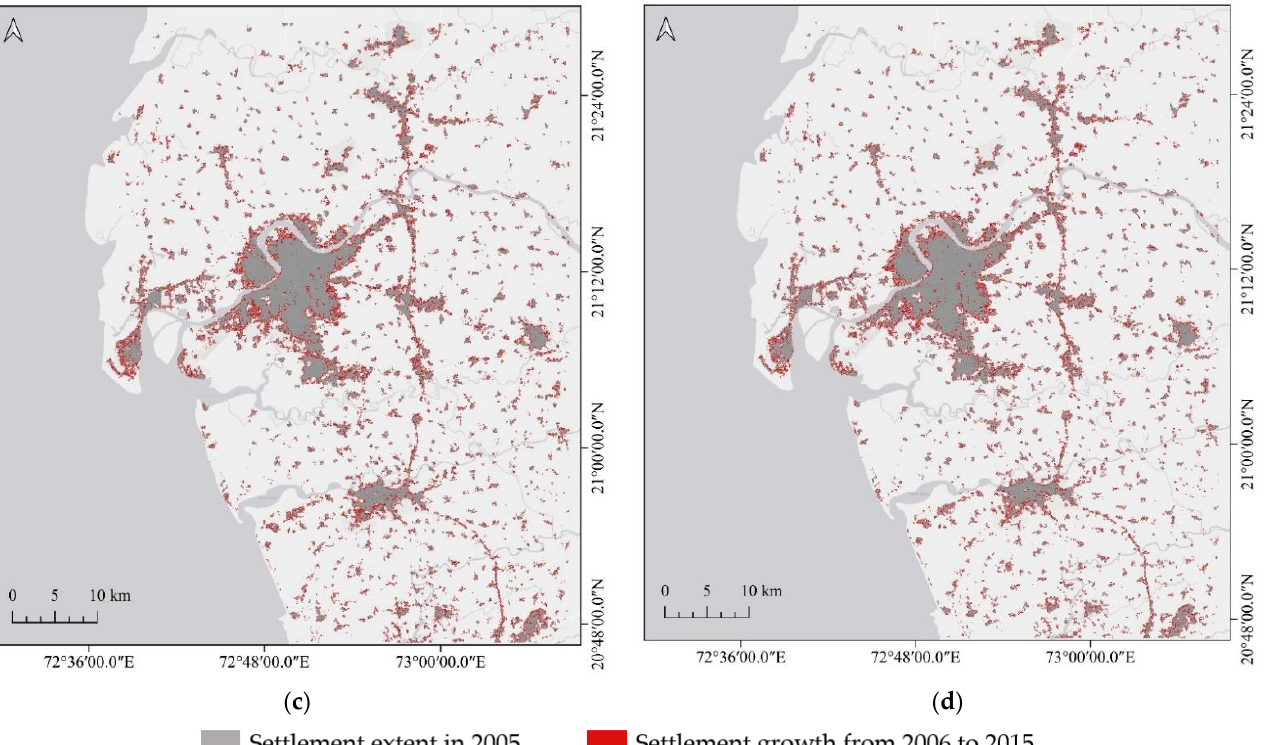
Figure 9. Actual settlement growth map and predicted settlement growth maps (2006–2015) of Surat, based on the STM-based model: ( a ) actual settlement growth map of Surat, generated from the WSF-evolution; ( b ) predicted settlement growth map based on the one-year strategy and RF; ( c ) predicted settlement growth map based on the ten-year strategy and RF; ( d ) predicted settlement growth map based on the ten-year strategy and MLP.